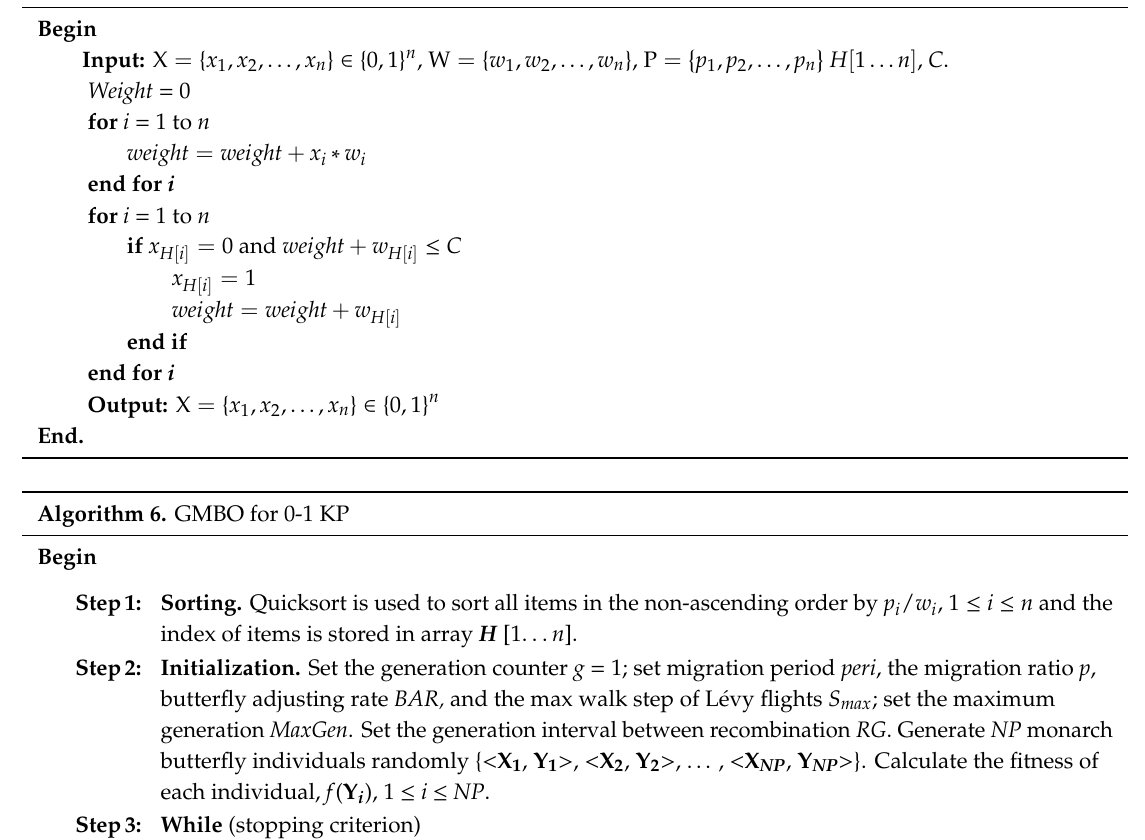
Algorithm 5. Greedy Optimization Operator